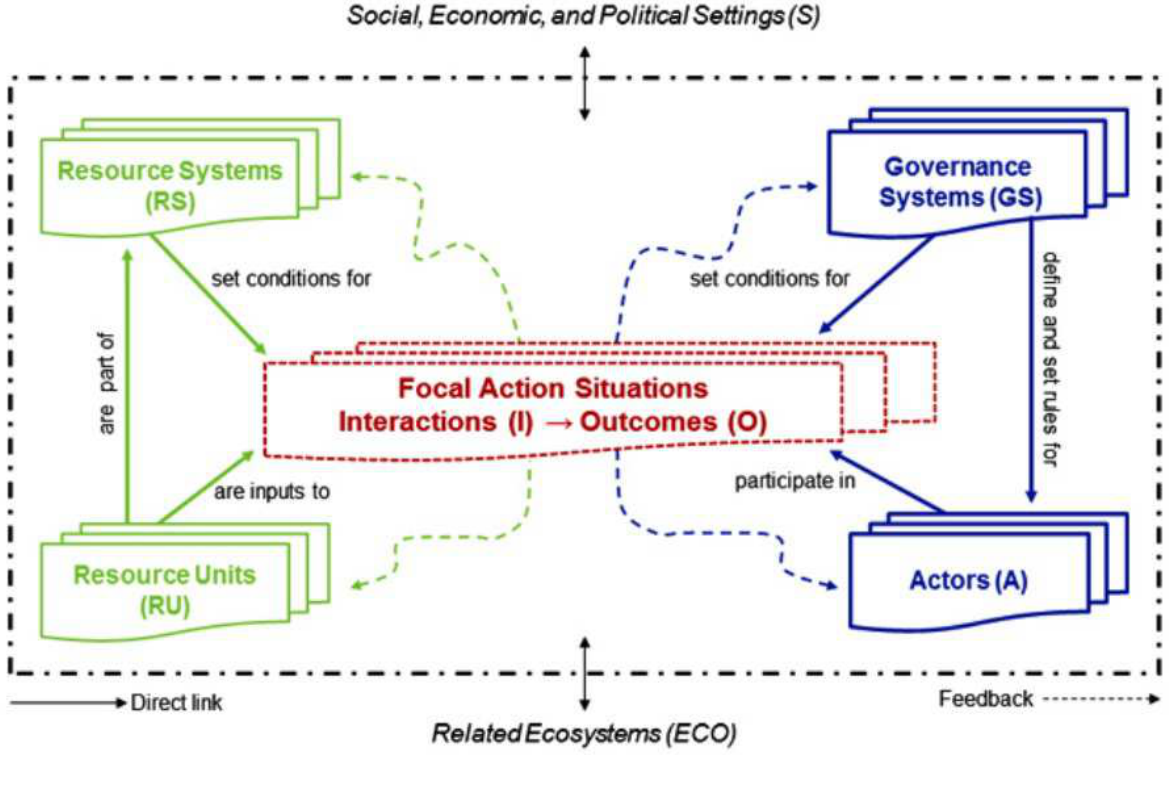
Figure A1.1 The SES framework first-tier variables in visual form (McGinnis & Ostrom, 2014).